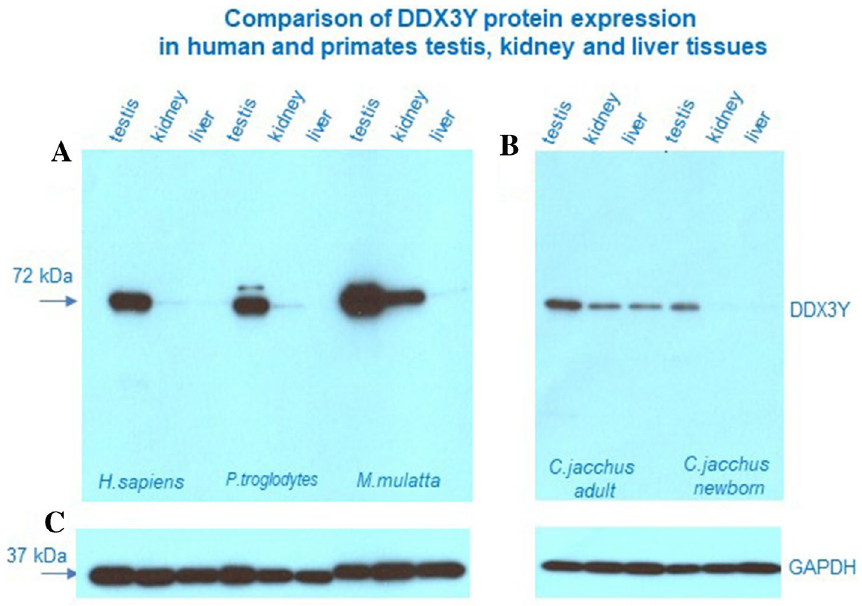
Figure 3. Immunoblotting experiments (Western blotting) with DBY-10, the DDX3Y-specific polyclonal antiserum 7 , are shown with protein extracts (each 10 µg) from testis, kidney, and liver tissue of human ( H. sapiens ), Pan troglodytes , Macaca mulatta and Callthrix jacchus in parallel. Cross-reaction with DDX3Y protein (MW = 72 kDa) was found mainly in testis tissue (10 min. exposure time). ( A ) In the old world monkey Macaca mulatta DDX3Y expression was also found in the kidney. ( B ) In the new world monkey, Callthrix jacchus, we found only, ow levels of DDX3Y expression in the adult and newborn monkeys. In the adult Callithix species, DDX3Y expression is found, not only in testis, but also in both somatic tissues; in the newborn phase, weak DDX3Y expression is found only in testis tissue. ( C ) Incubating the same blots subsequently with a specific antiserum against GAPDH (MW = 37 kDa) demonstrates similar sample loading in each blot lane (5 min. exposure time). Based on the comparable GAPDH intensities we conclude that strongest DDX3Y expression was found in the testis tissue of Macaca mulatta and testis specific DDX3Y expression only in human and Pan troglodytes ( A ). For improving clarity and conciseness of this Western blot presentation original blot pictures have been cropped as described in detail in Supplementary Fig. S4. Molecular Weights (MW: kDa) given at the left of the cropped blot pictures correspond to those of DDX3Y and GAPDH, respectively, as indicated on the